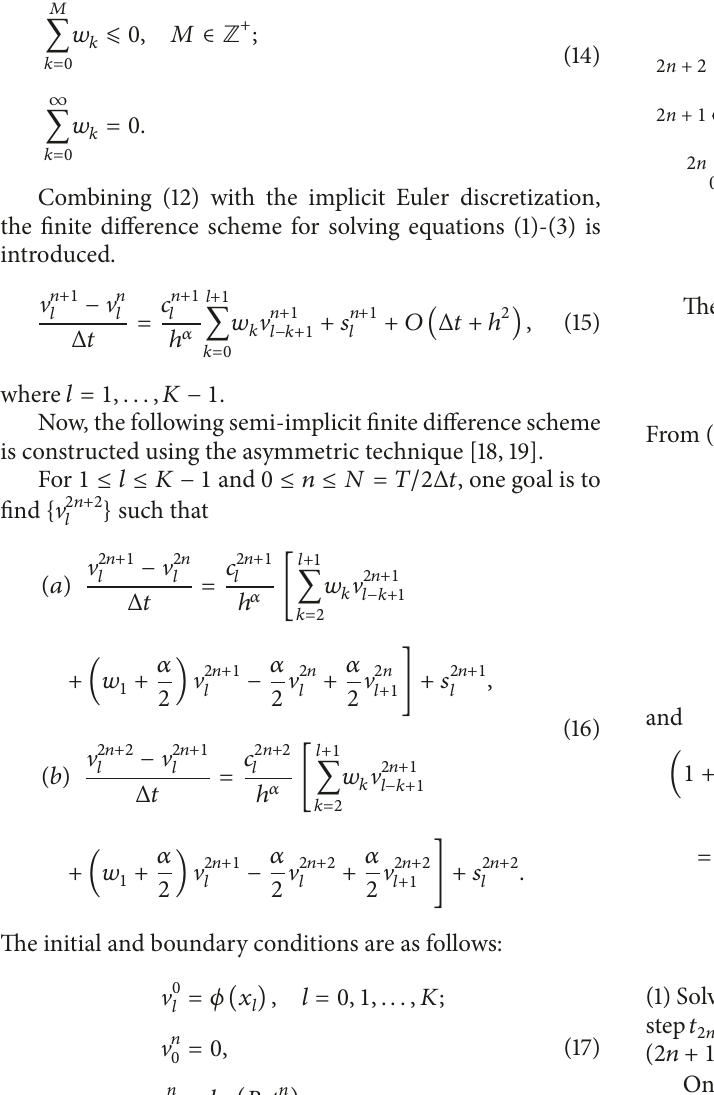
Figure 2: The finite difference stencil for point ( 𝑙